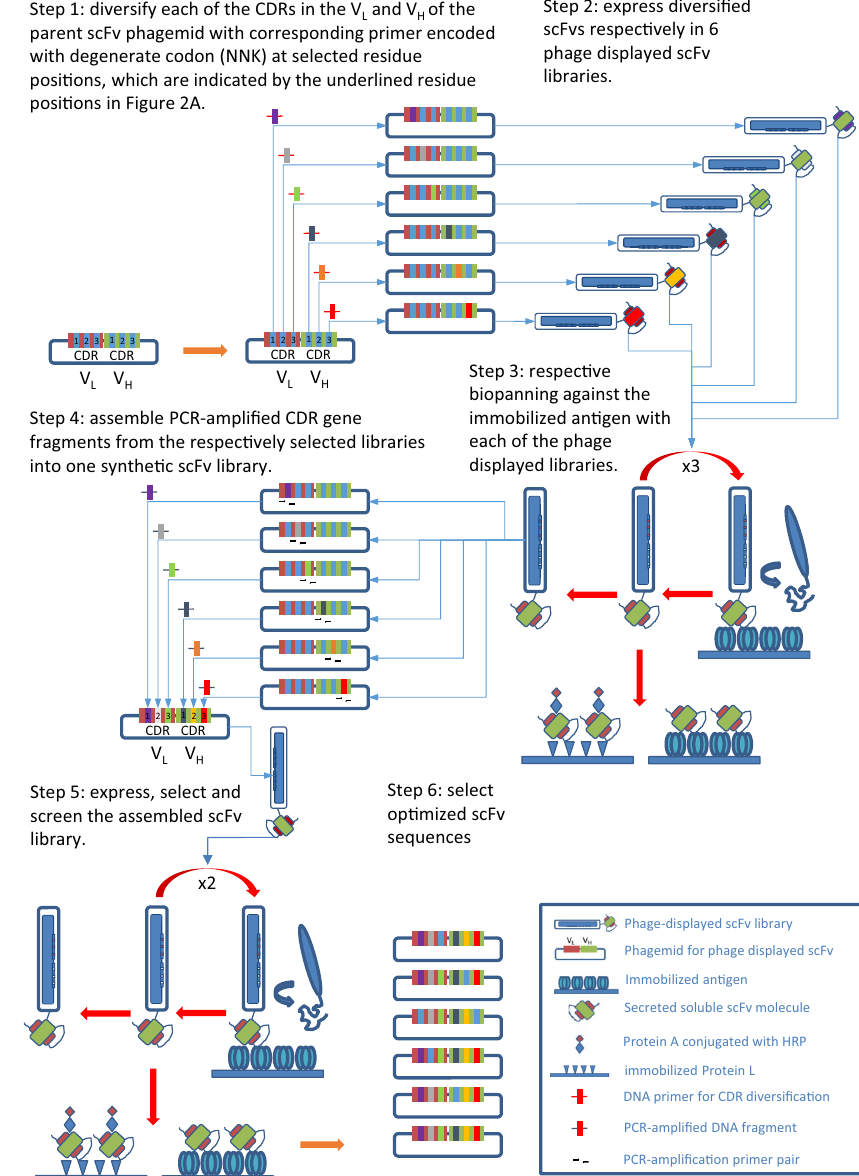
Figure 1. Schematic depiction of the methodology based on phage-displayed synthetic antibody libraries to explore CDR sequences of the M9-derived antibodies binding to MSLN on the same epitope as that of M9. The step-by-step procedures described in the figure are elaborated in “Methods” section. The experimental details followed the procedures previously published 25,27,33